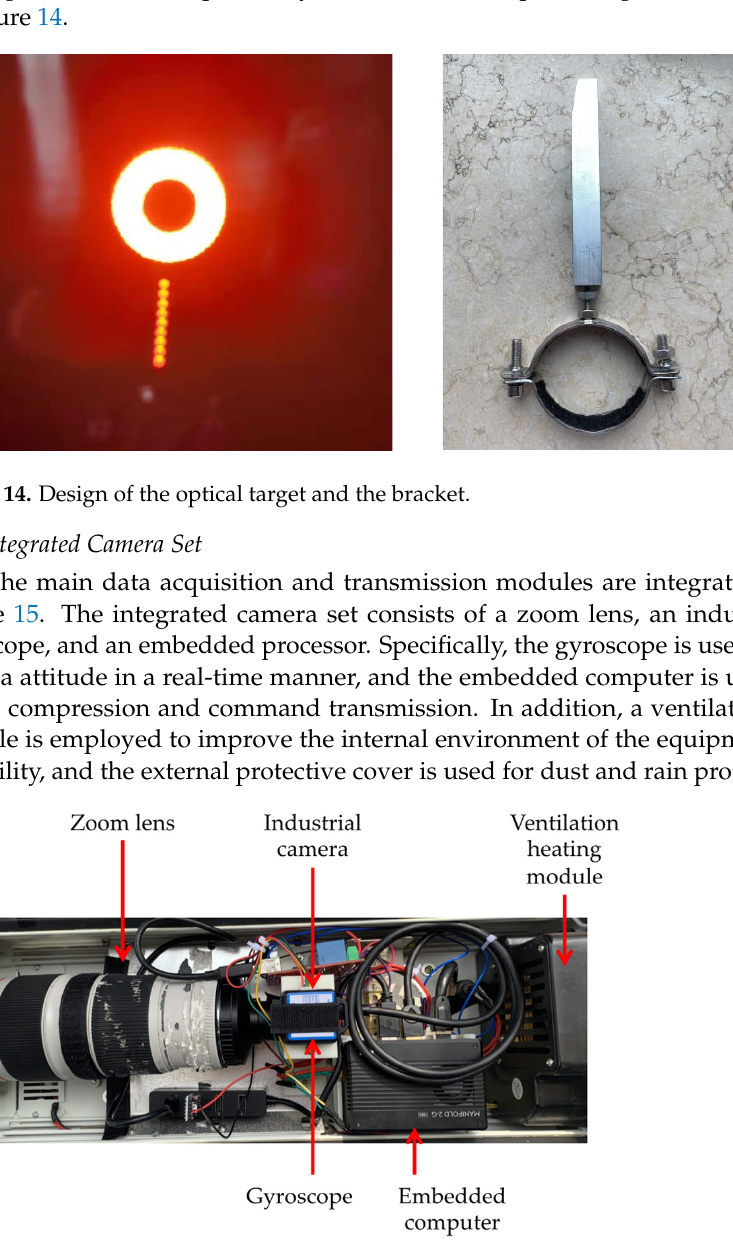
Figure 13. Vision-based system for relative sag measurement.